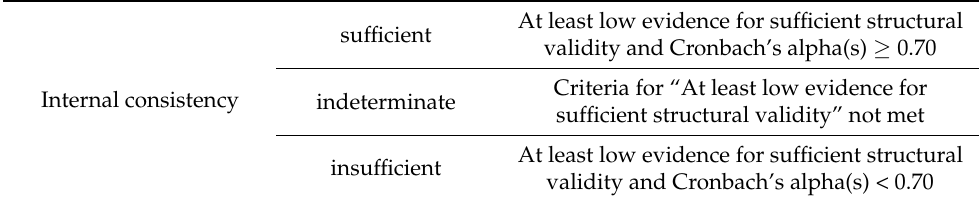
Table 2. Updated criteria for good measurement properties—internal